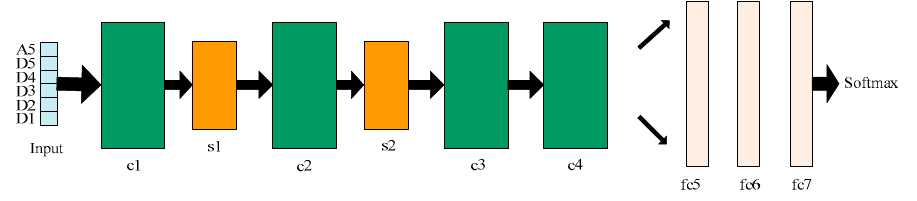
Figure 3. Structure of the deep neural network.